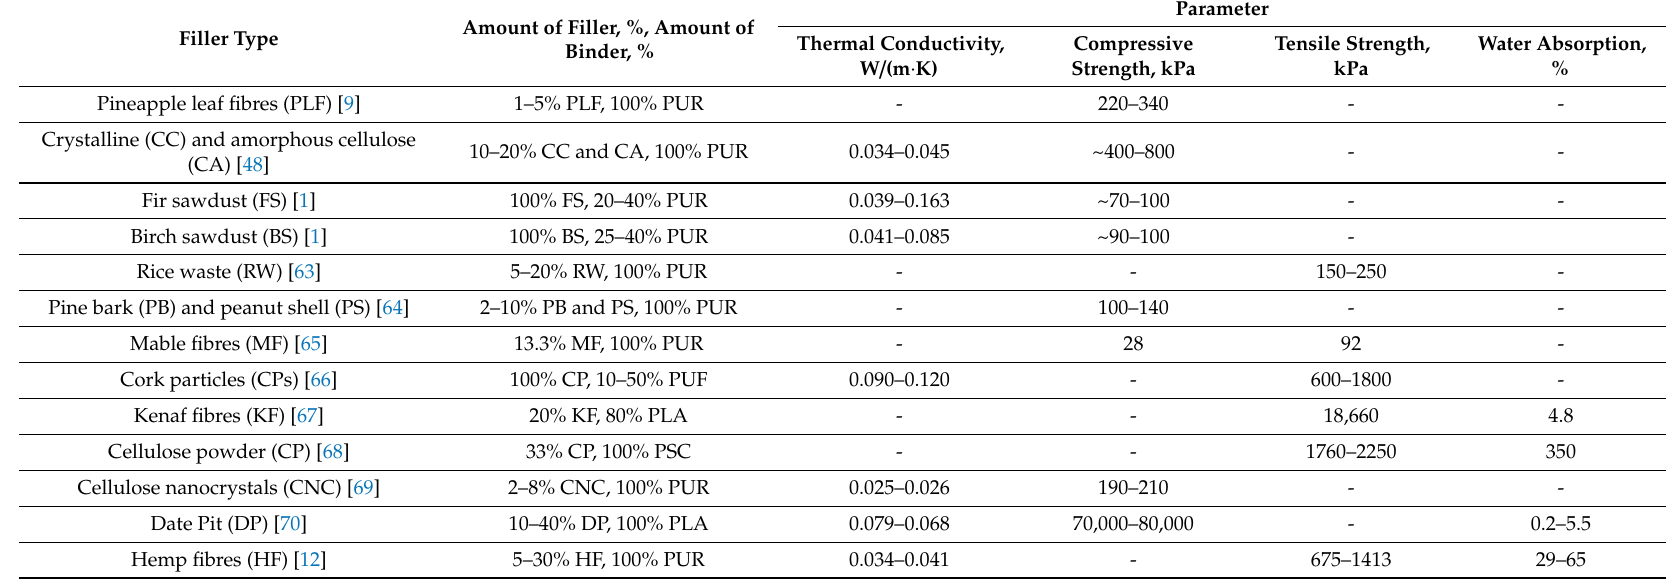
Table 8. Properties of polymer-based biocomposite foams with WW-based